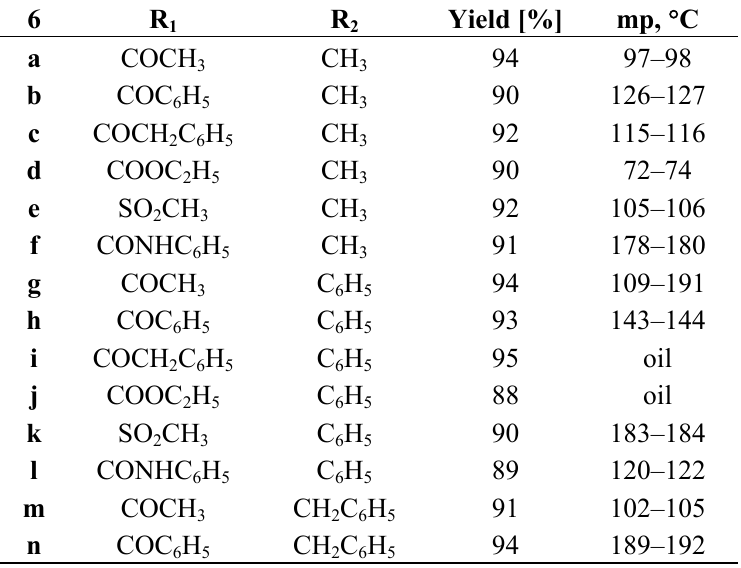
Table 4. Synthesis of 1-substituted 1,2,3,4-tetrahydroisoquinolines.